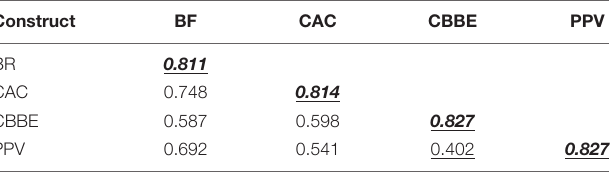
TABLE 2 | Discriminant validity (Fornell-Larker-1981 Criteria). Construct